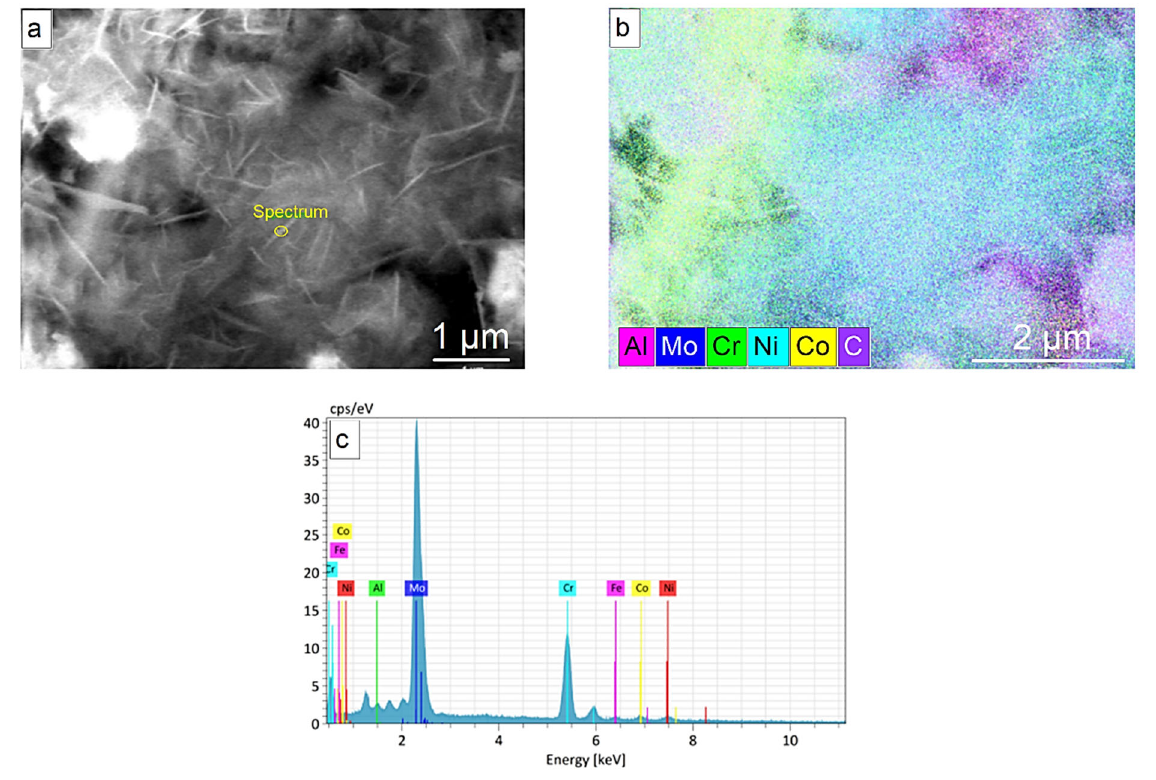
Figure 7. SEM image ( a ), elements distribution map ( b ) and x-ray microanalysis spectrum ( c ) in the area with predominance of lamellar phase.